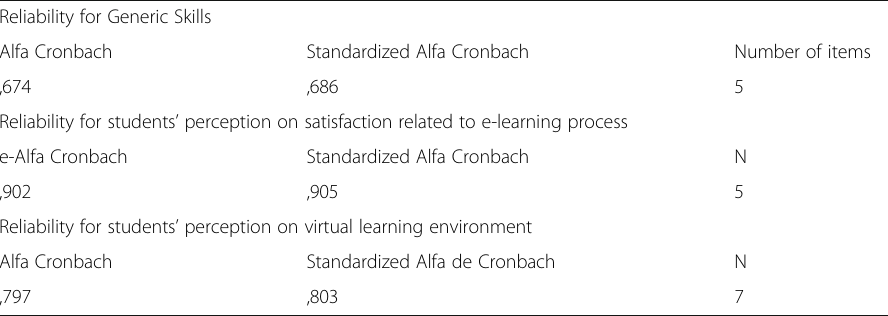
Table 2 Reliability by